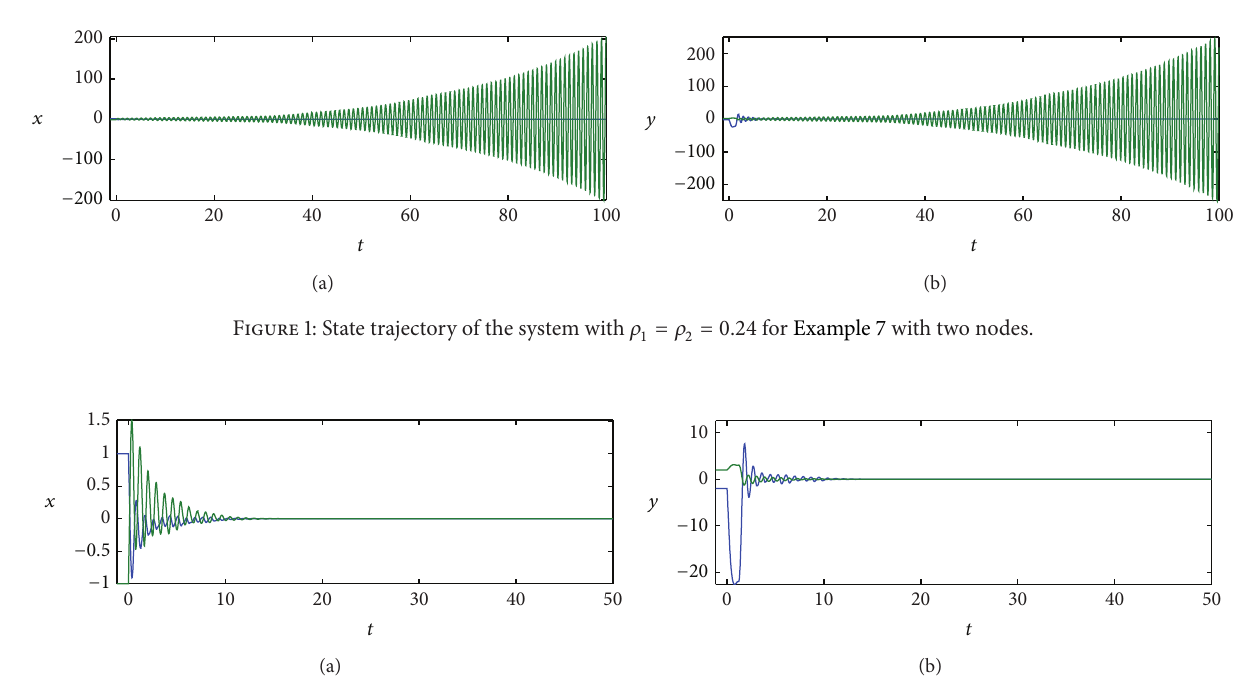
Figure 2: State trajectory of the system with 𝜌 1 = 𝜌 2 = 0.13 for Example 7 with two nodes.